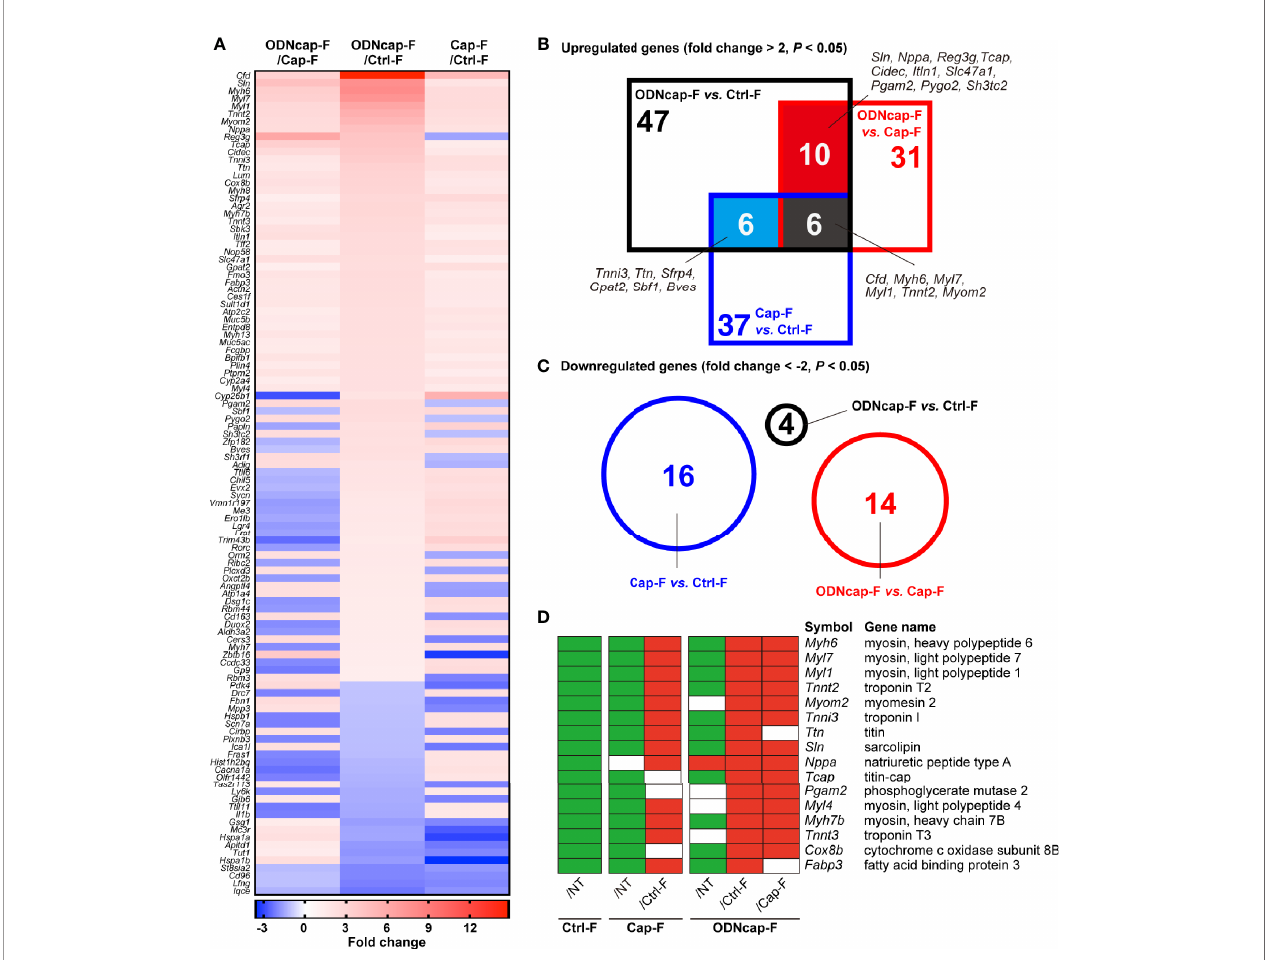
FIGURE 5 | Transcriptomic pro fi ling in the lungs. Lungs were collected on Day 70. Total RNA from the lungs was subjected to DNA microarray analysis ( n = 2). (A) A heatmap shows 108 genes that were differentially expressed among the OVA-sensitized/challenged groups ( P < 0.05 by local-pooled-error tests and |fold change| > 2). (B, C) Venn diagrams show signi fi cantly upregulated (B) and downregulated (C) genes ( P < 0.05 by local-pooled-error tests and |fold change| > 2). (D) Panels visualize differences in the expression of cardiac muscle-related genes among all experimental groups. Green and red boxes represent signi fi cantly downregulated and upregulated expression, respectively ( P < 0.05 by local-pooled-error tests). No signi fi cant differences are indicated as blank (white) boxes. The P values were adjusted using an FDR